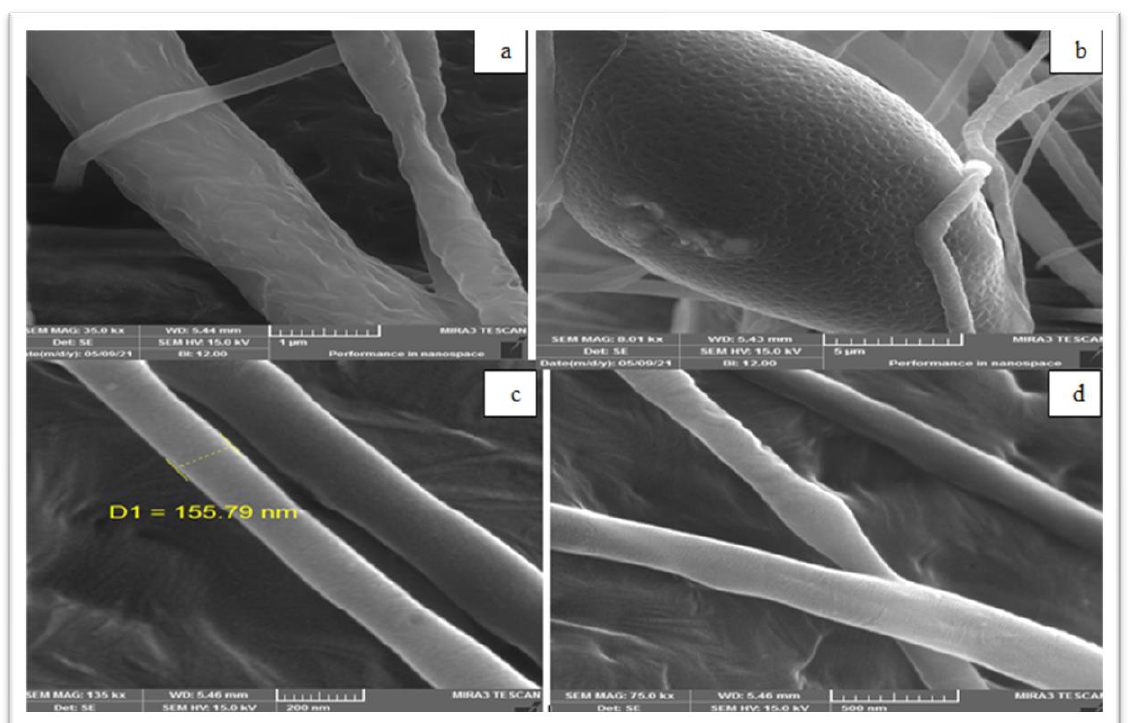
Figure 7: FESEM of PCL /HA 1/ 0.4 at different